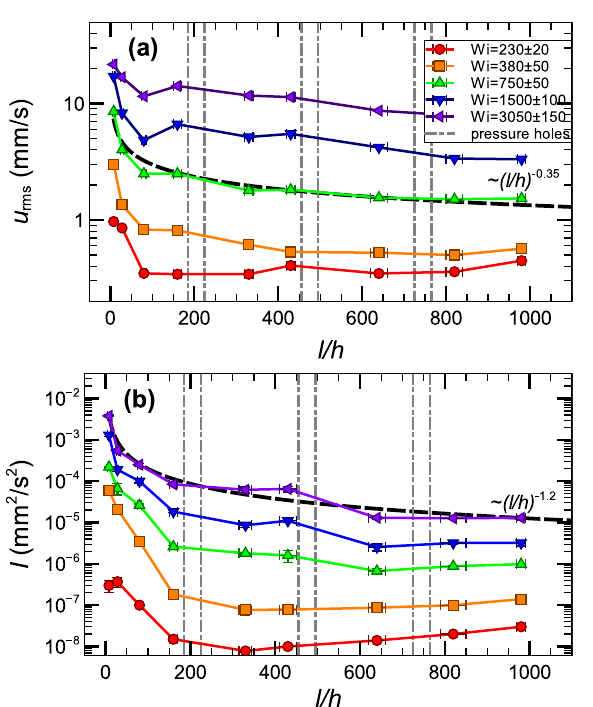
Figure 6. Decay of rms of velocity fluctuations u rms and elastic waves intensity I along the channel length for different Wi . Dependence of u rms ( a ) and I ( b ) on l / h at 5 values of Wi , presented in different colors, in three flow regimes: transition, ET, and DR. The u rms and I decays with l / h are algebraically fitted with the exponents of − 0.35 and − 1.2, respectively, as